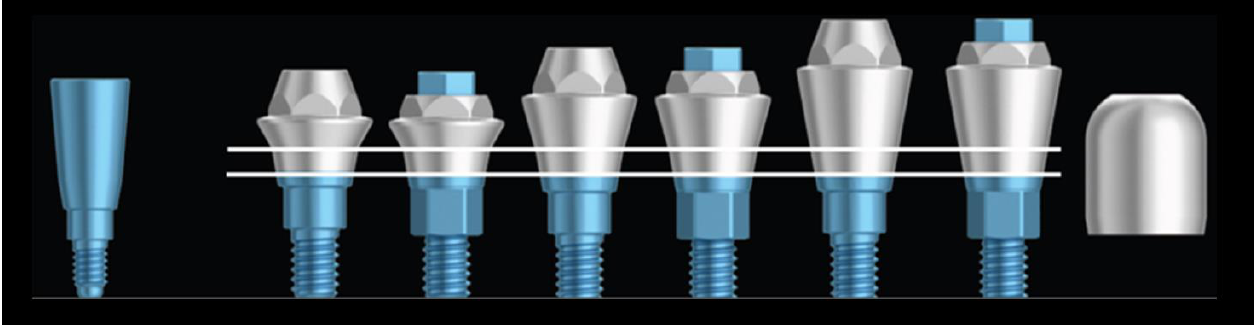
Figure 2. From left to right: healing abutment 5 mm height, Permanent ® abutments of 1, 2, and 3 mm height to unitary and multiple rehabilitations, and protective cover for Permanent ® abutment.